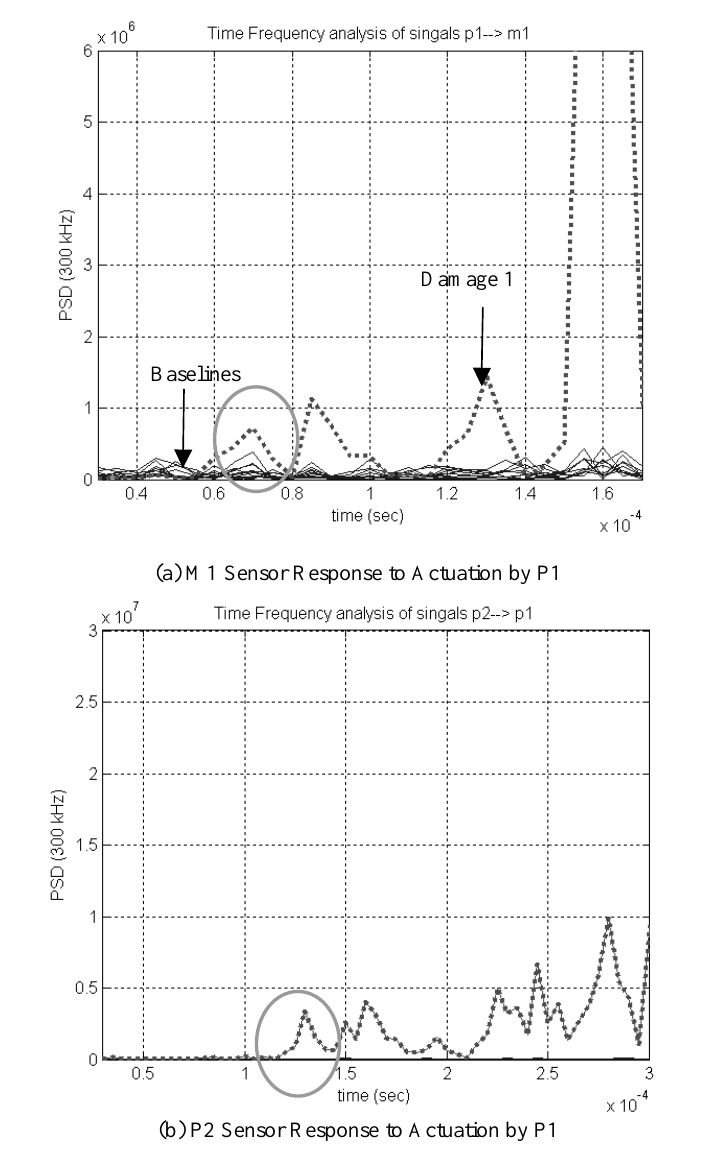
Fig. 12. Time-Frequency Analysis (300 kHz). First reflection indicated in circles (a) M1 Sensor Response to Actuation by P1; (b) P2 Sensor Response to Actuation by P1. no changes are observed in any other actuator-sensor pairs. This result indicates that the region between P1 and P3 contains the damage, as shown in Figs 11 (a) and (b). Once the damaged region is identified, the pulse-echo analysis is performed to locate the damage site. For this process, a time-frequency analysis was performed on baseline and damage cases. Analyzing time and frequency components simultaneously produces a clearer indication of the arrival of the reflected waves. In the time-frequency analysis, changes in the power spectral density (PSD) corresponding to 300 kHz, which is the frequency of the input Lamb wave, are recorded as a function of time. The PSD is defined as the amount of power per unit of frequency as a function of the frequency. Mathematically, it is defined as the Fourier transform of the autocorrelation sequence of the time series. The magnitude of the algebraic difference between the test and baseline PSDs are processed with the time-frequency